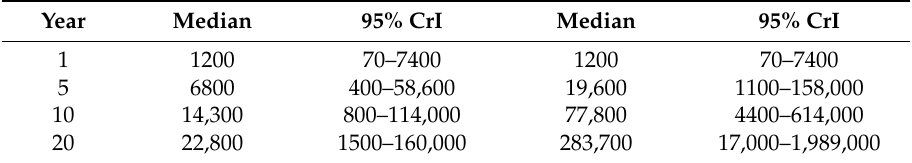
Table 2. Point and interval estimates for the annual and cumulative numbers of pan-drug-resistant (PDR) Gram-negative bacteraemia in the UK for selected years of the scenario. CrI, credibility interval.